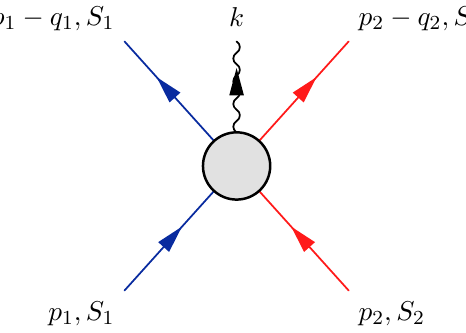
Figure 1 . Bremsstrahlung (outgoing graviton) emitted during the scattering of two spinning massive bodies (massive spin- s quantum particles) exchanging gravitational/electromagnetic